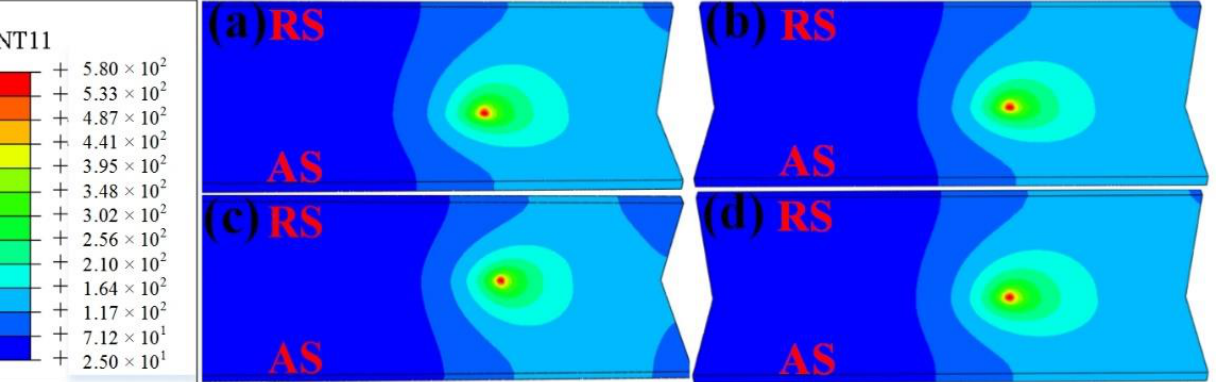
Figure 6. Contours of the temperature fields at different phases in SSFSW process at various rotation speeds: ( a ) 1500 rpm; ( b ) 1750 rpm; ( c ) 2000 rpm; ( d ) 2250 rpm.